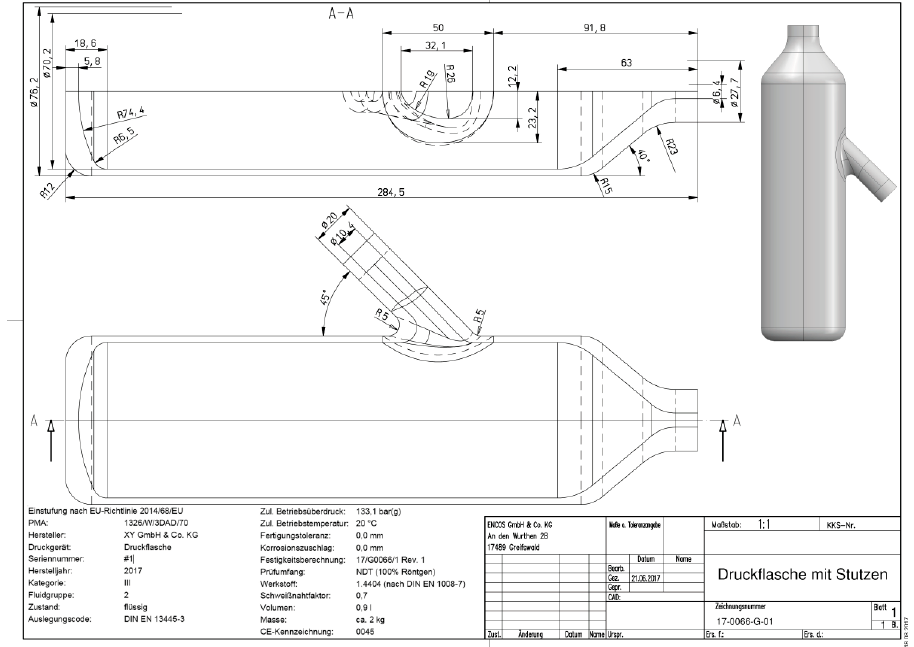
Figure 1. Technical drawing of the experimental pressure vessel model [20].